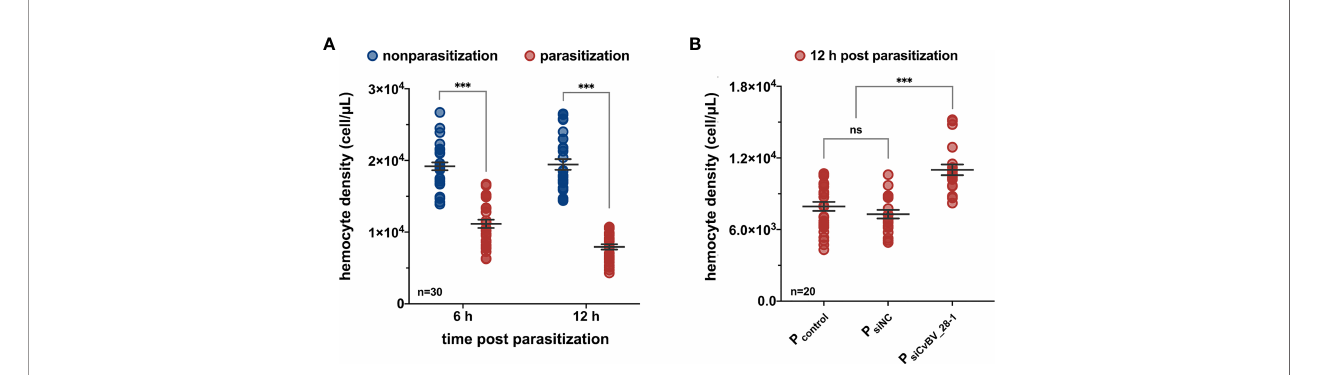
FIGURE 3 | CvBV_28-1 decreases the number ofhemocytes in parasitized P. xylostella . (A) The hemocyte density of parasitized and nonparasitized P. xylostella larvae 6 h and12 h post-parasitization. 30 independent biological replicates were performed andshownas dots. Data are presented as the mean values ± SD. Differences between groups were analyzed by two-way ANOVA with S ̌ ida ́ k ’ s multiplecomparisons test (***p < 0.001). (B) The hemocyte density of parasitized P. xylostella larvae injectedwith siCvBV_28-1 (P siCvBV_28-1 ) 12 h post-parasitization. Parasitized P. xylostella larvae (P control ) and siNC-injectedparasitized P. xylostella larvae (P siNC ) served as controls. 20 independent biologicalreplicates were performedand shown as dots. Data arepresentedas the mean values ± SD.Differences between groups were analyzedby one-way ANOVA with Tukey ’ s multiple comparisonstest (***p < 0.001; ns: not signi fi